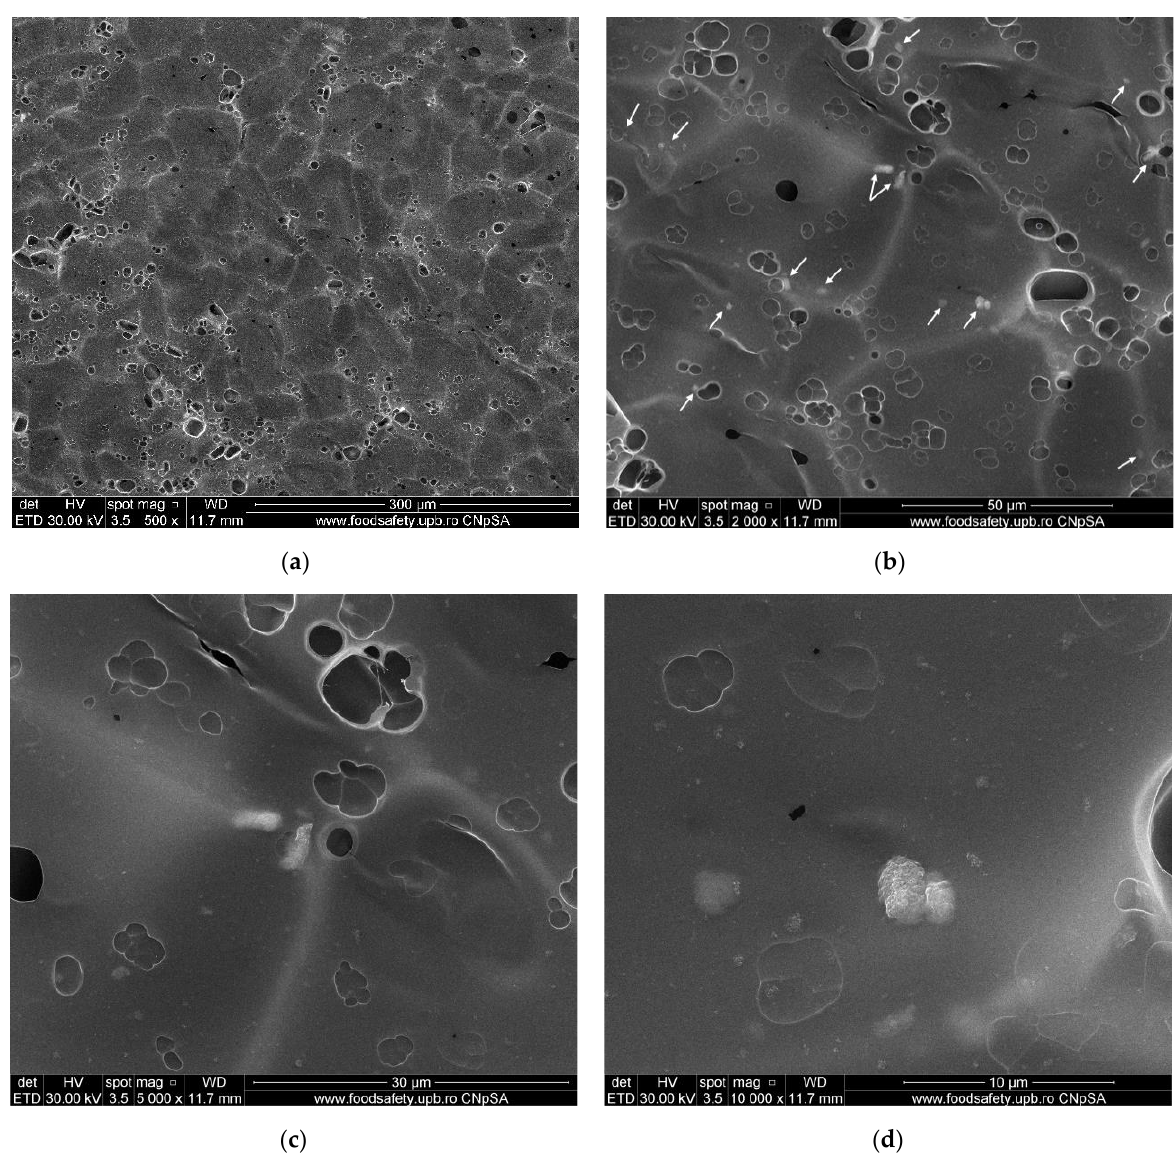
Figure 10. SEM images of chitosan/TiO 2 5%: ( a ) 500× magnification, ( b ) 2000× magnification, ( c ) 5000× magnification and ( d ) 10,000× magnification. EDX analysis (Figure 11a,b) indicates the elemental composition of the tested